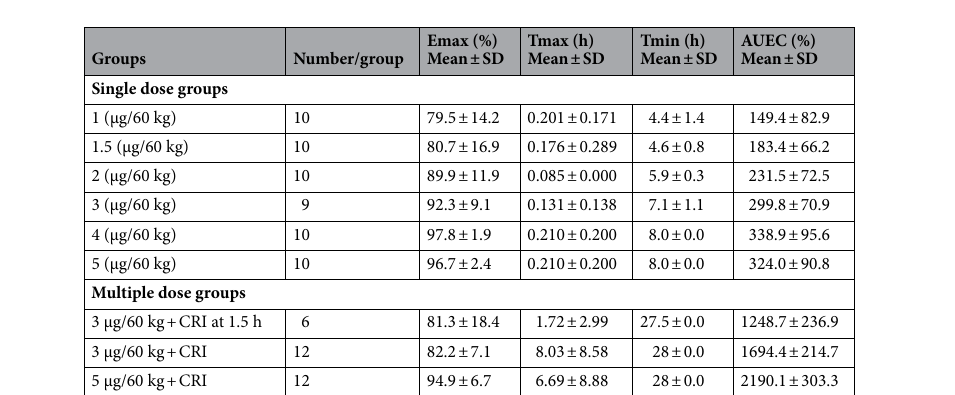
Table 1. Anfibatide pharmacodynamic effects in healthy volunteers. CRI, constant rate infusion; Emax, maximal effect on inhibition of ristocetin-induced platelet aggregation; Tmax, time to Emax; Tmin, time of minimal inhibitory effect on platelet aggregation; AUEC, area under the effect curve.